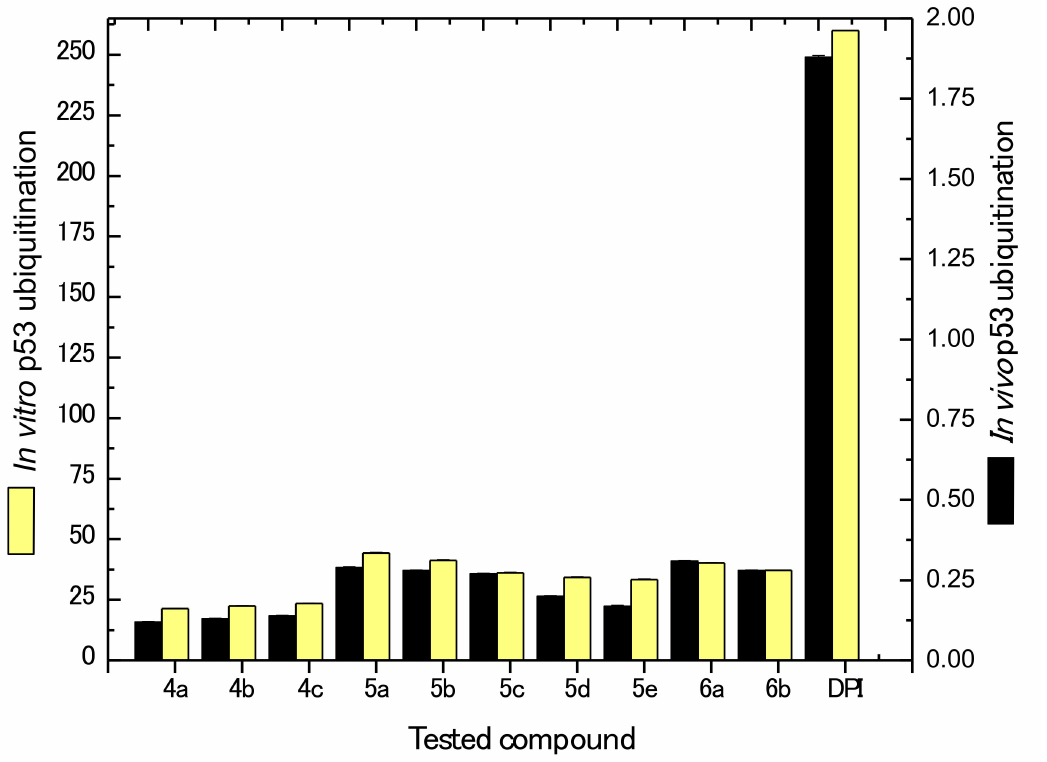
Figure 4. In vitro and in vivop53 ubiquitination of the newly synthesized